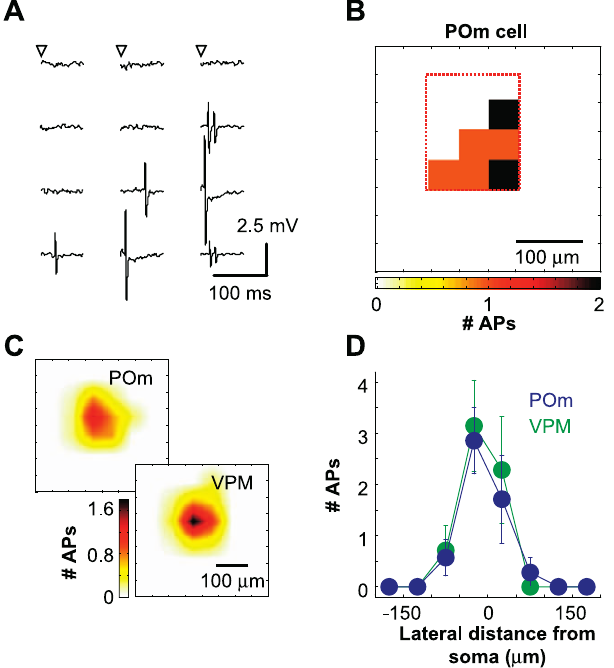
Figure 2. Spatial Resolution of LSPS in the Somatosensory Thalamus (A) Photostimulation-evoked APs recorded in loose-patch mode in a POm cell (arrowheads indicate the stimulus). The traces correspond to the 12 pixels in the boxed region shown in (B). (B) Excitation profile of a single POm cell. The grid was centered on the soma. Pixel values encode the number of APs in a 100-ms window after photostimulation. (C) Average excitation profiles (VPM, n ¼ 7; POm, n ¼ 7). (D) Excitation as a function of lateral distance from the soma (at 0). Responses elicited in each column of the 8 3 8 grid were summed. DOI: 10.1371/journal.pbio.0040382.g002